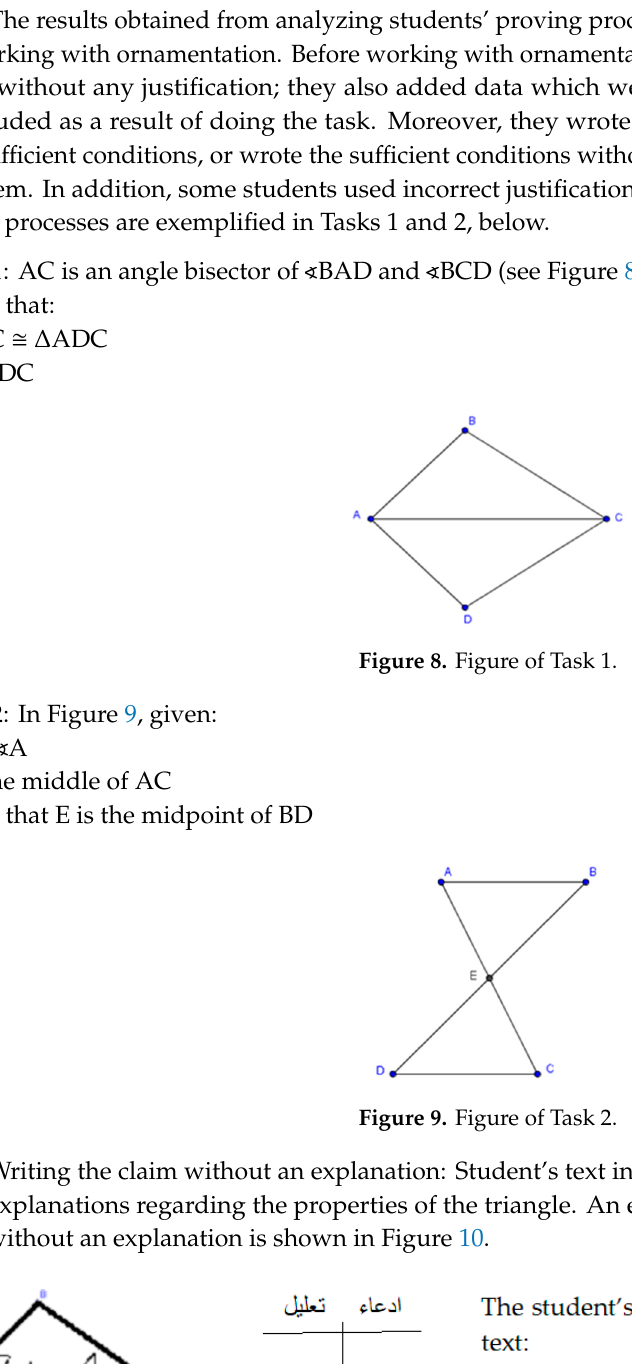
Figure 7. The seventh ornamentation.